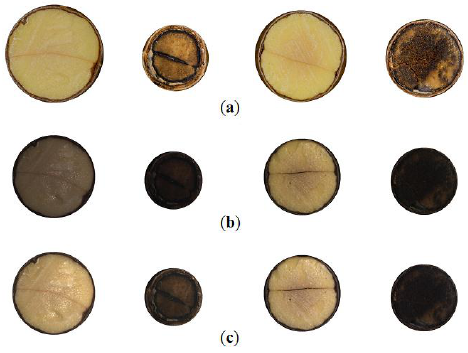
Figure 5. Value of correction gain factor in automatic normalization of images: ( a ) acquired by machine vision camera; ( b ) captured by high resolution camera.